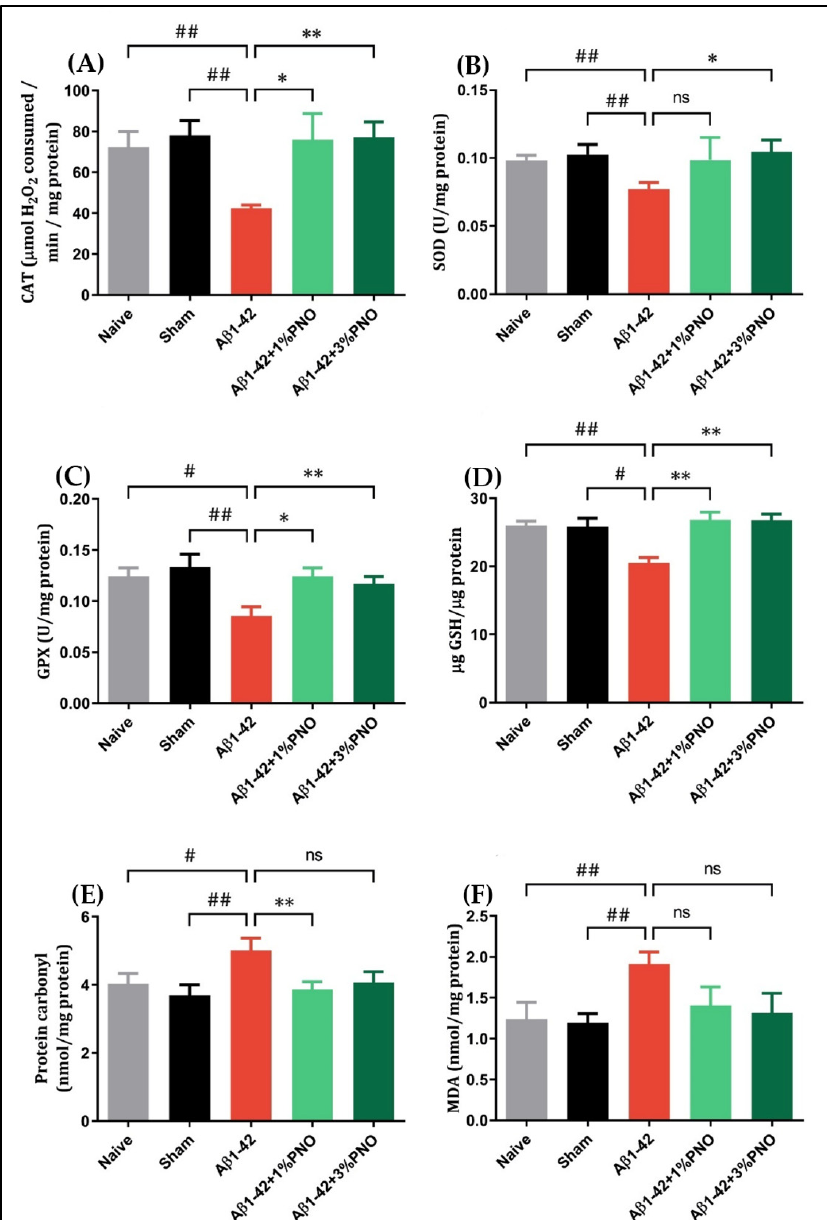
Figure 6. Effects of the inhaled Pinus halepensis essential oil (PNO, 1%, and 3%) on ( A ) catalase (CAT), ( B ) superoxide dismutase (SOD), ( C ) glutathione peroxidase (GPX), ( D ) total content of reduced glutathione (GSH), ( E ) protein carbonyl, and ( F ) malondialdehyde (MDA) in the amygdala of A β 1-42-treated rats. Values are means ± S.E.M. ( n = 5). ( A ) A β 1-42 vs. Naive: ## p = 0.0025; A β 1-42 vs. sham: ## p = 0.0027; A β 1-42 vs. A β 1-42 + 1% PNO: * p = 0.0238 and A β 1-42 vs. A β 1-42 + 3% PNO: ** p = 0.0047. ( B ) A β 1-42 vs. Naive: ## p = 0.0041; A β 1-42 vs. sham: ## p = 0.0066 and A β 1-42 vs. A β 1-42 + 3% PNO: * p = 0.0364. ( C ) A β 1-42 vs. Naive: # p = 0.0255; A β 1-42 vs. sham: ## p = 0.0027; A β 1-42 vs. A β 1-42 + 1% PNO: * p = 0.0231 and A β 1-42 vs. A β 1-42 + 3% PNO: ** p = 0.0034. ( D ) A β 1-42 vs. Naive: ## p = 0.0020; A β 1-42 vs. sham: # p = 0.0103; A β 1-42 vs. A β 1-42 + 1% PNO: ** p = 0.0053 and A β 1-42 vs. A β 1-42 + 3% PNO: ** p = 0.0037. ( E ) A β 1-42 vs. Naive: # p = 0.0157; A β 1-42 vs. sham: ## p = 0.0084 and A β 1-42 vs. A β 1-42 + 1% PNO: ** p = 0.0051. ( F ) A β 1-42 vs. Naive: # p = 0.0357 and A β 1-42 vs. sham: ## p = 0.0084; ns: non-significant.